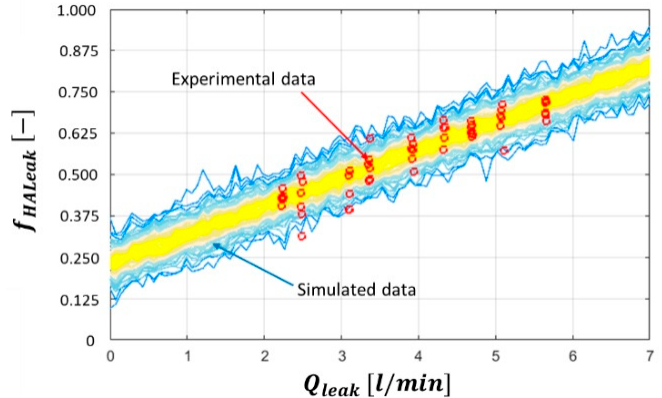
Figure 7. Feature behavior for increasing internal